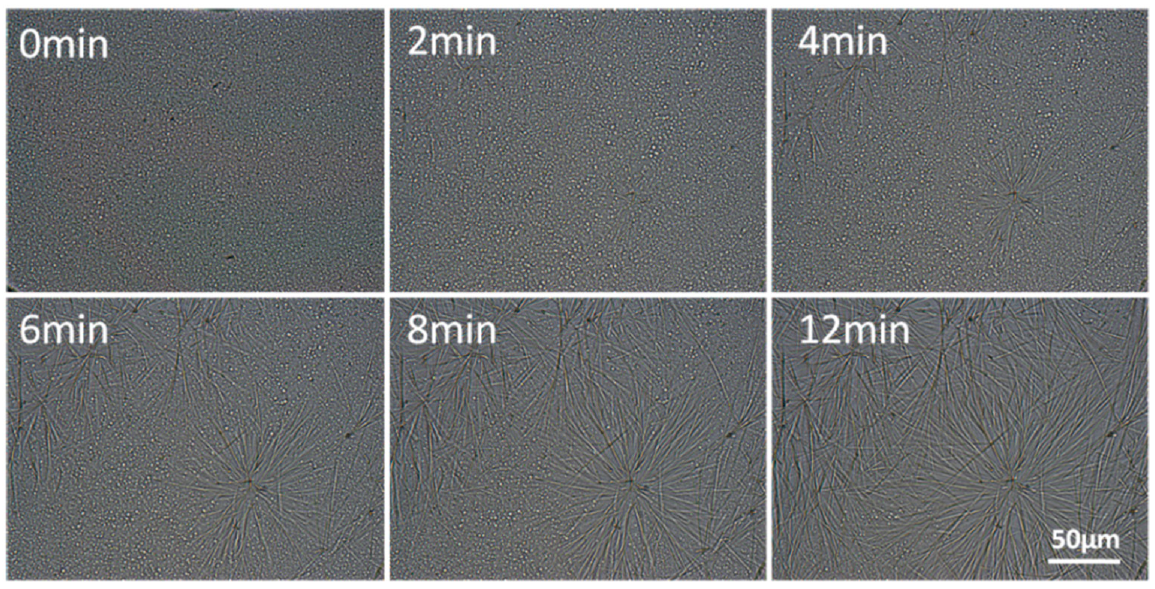
Figure 6. Hot-stage OM photographs of MPT5-130 isothermal at 80 °C.